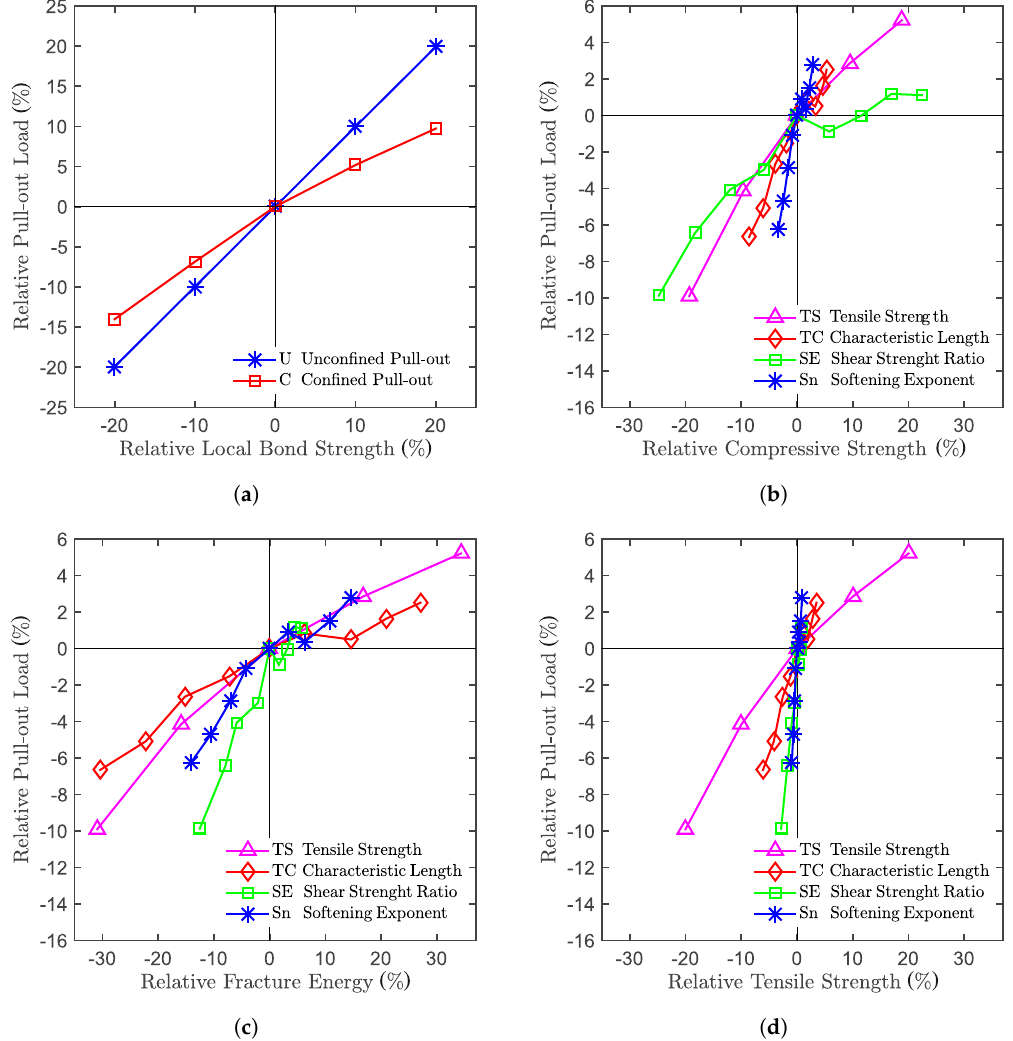
Figure 11. Numerical model sensitivity study. Relation between anchor capacity and: ( a ) local bond strength; ( b ) cube compressive strength; ( c ) fracture energy; ( d ) and tensile